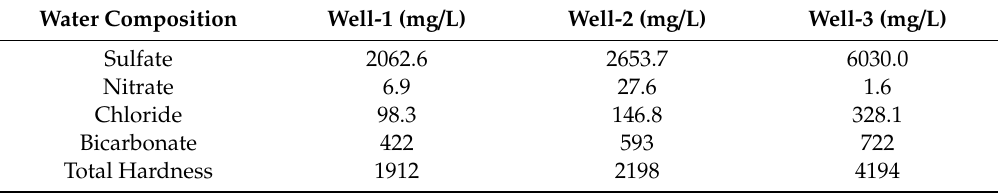
Table 5. Anion concentration and total hardness (calculated) of the groundwater samples. Water